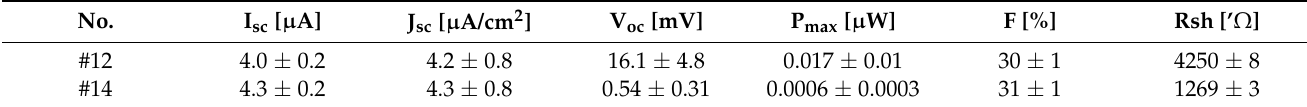
Figure 6. ( a ). Light I-V and P-V characteristics of heterojunctions for #12. ( b ). Light I-V and P-V characteristics of heterojunctions for #13. Table 5. The results of solar cells based on copper oxide and titanium